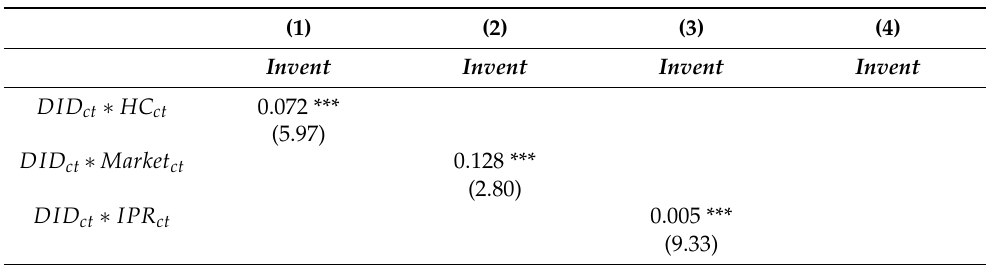
Table 4. Heterogeneity analysis and spatial spillover